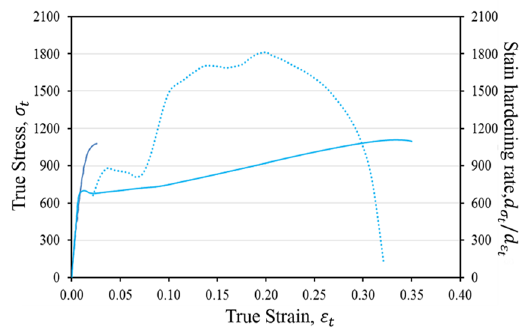
Figure 7. ( a ) Room-temperature true stress-strain curves of 820–2 M and 820–5 M alloys at a strain rate of 5 × 10 − 4 in tension. The corresponding strain hardening rate as a function of true strain for 820–5 M was shown in dashed